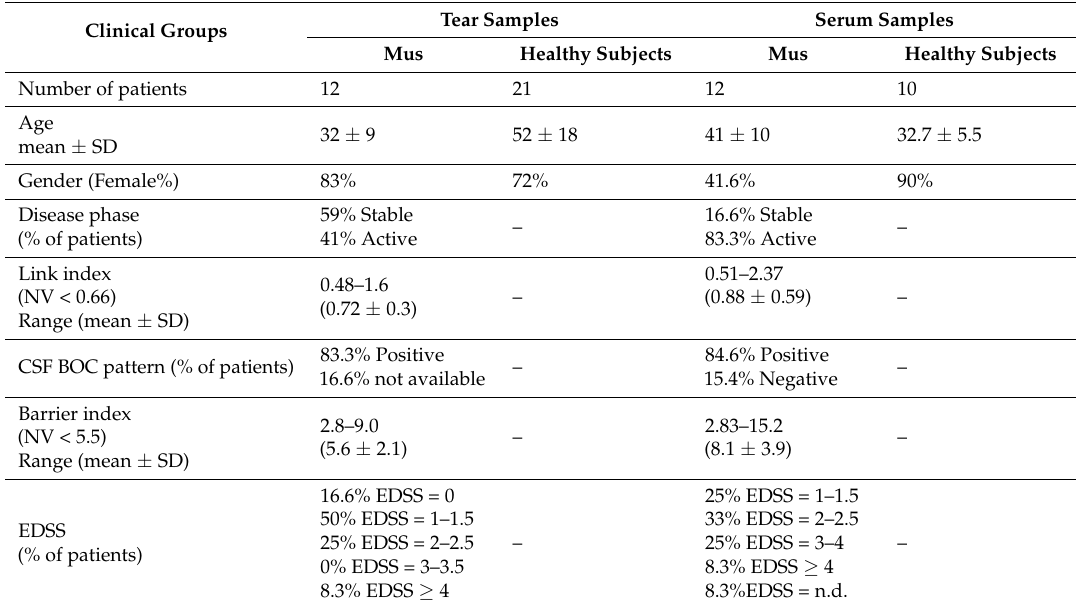
Table 2. Clinical and demographic features of the enrolled patients. NV = Normal Value, EDSS = Expanded Disability Status Scale, SD = Standard